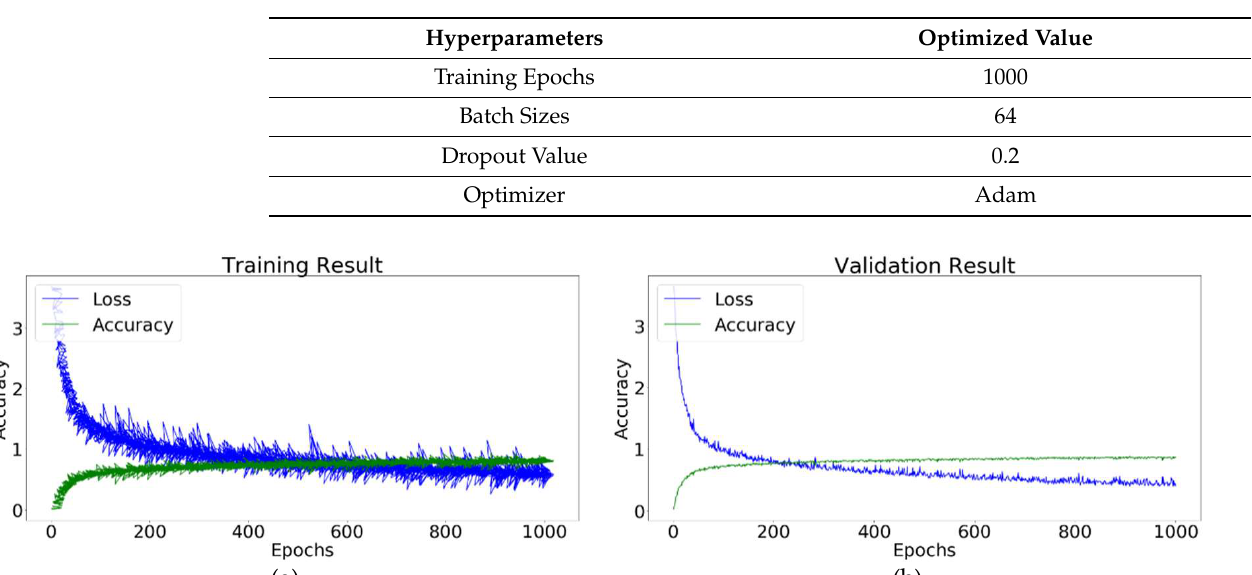
Table 3. Optimized hyperparameters of the Conv-4 DCNN.